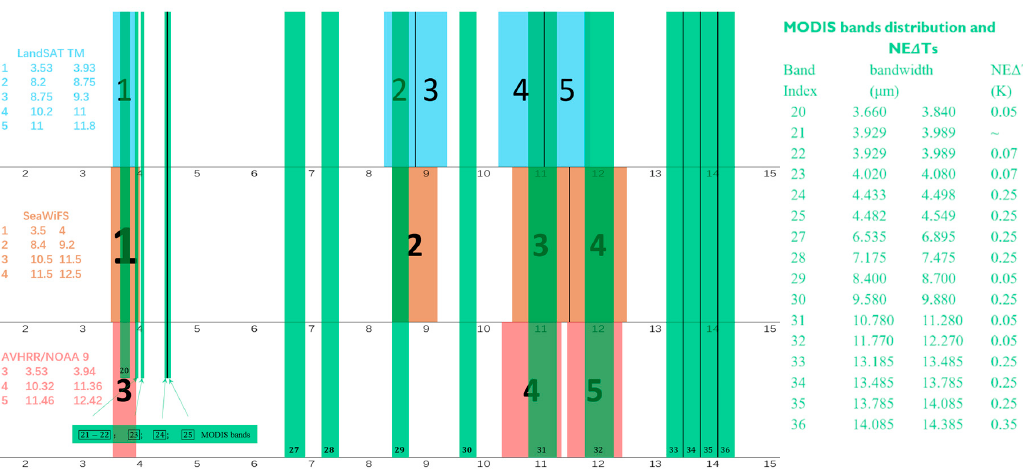
Figure A1 . Diagram of the weak temperature dependence of 𝜀 (cid:3036) (cid:3435)𝛺(cid:4652)⃗,𝑇 (cid:3046) (cid:3439) on NOAA/AVHRR channel 3 in an extreme instance of coarse sands.